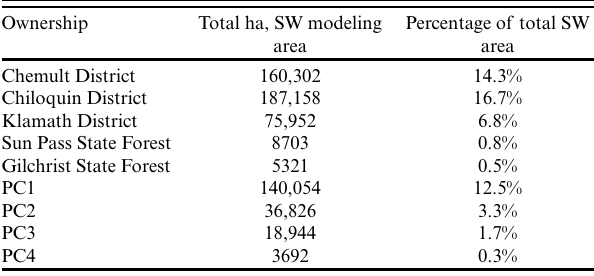
Table 1. Land ownership size, modeling